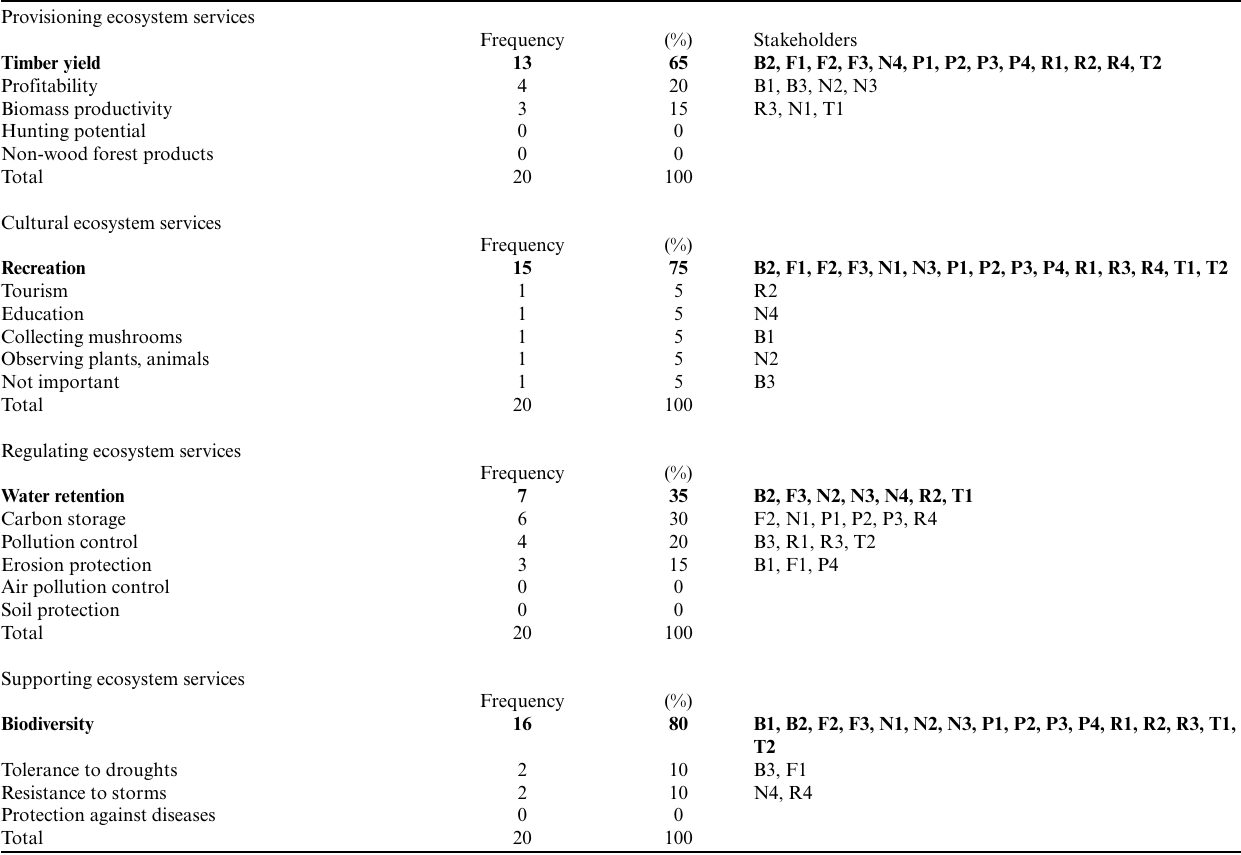
Table 2 . Frequency of responses on prioritized ES in each category. The ecosystem services named most frequently as priority are in bold. Provisioning ecosystem